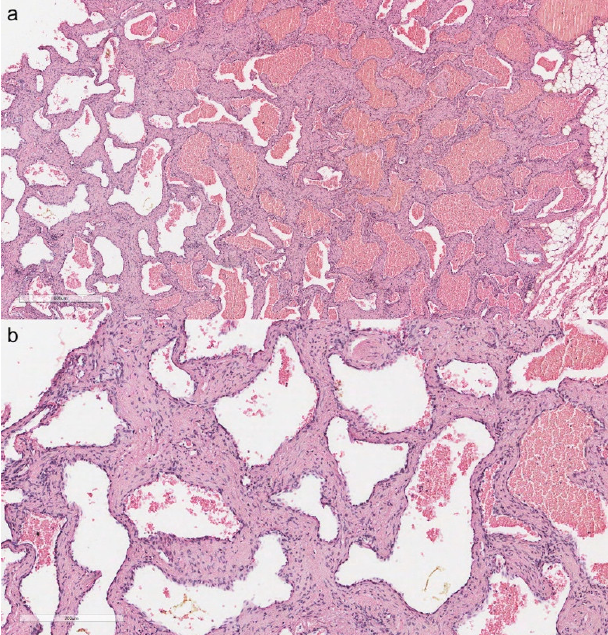
Figure 5. Cavernous hemangioma ( a , hematoxylin and eosin, original magnification ×40). Dilated vessels lined by a single layer of flat endothelial cells were evident. Vascular spaces were separated by fibrous septa containing small vessels. No cytologic atypia or mitoses were detected ( b , hematoxylin and eosin, original magnification ×100).